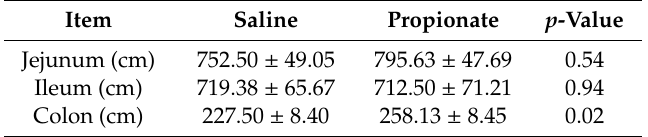
Table 2. E ff ects of the cecal infusion of sodium propionate on the length of di ff erent intestinal segments.